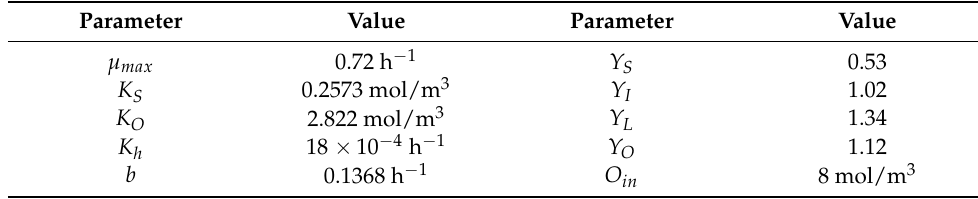
Table 1. Parameters’ values for the composting model